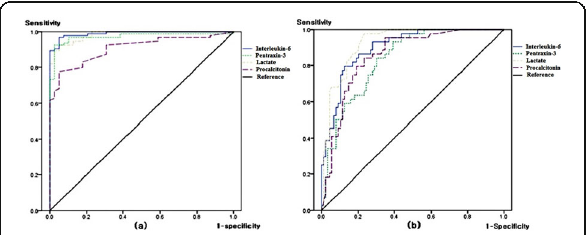
Fig. 2 (abstract P14). Receiver Operating Characteristic (ROC) Curves to Discriminate Sepsis (a) and Septic Shock (b) by Interleukin- 6, Pentraxin-3, Lactate, and Procalcitonin Levels Measured in the Emergency Department